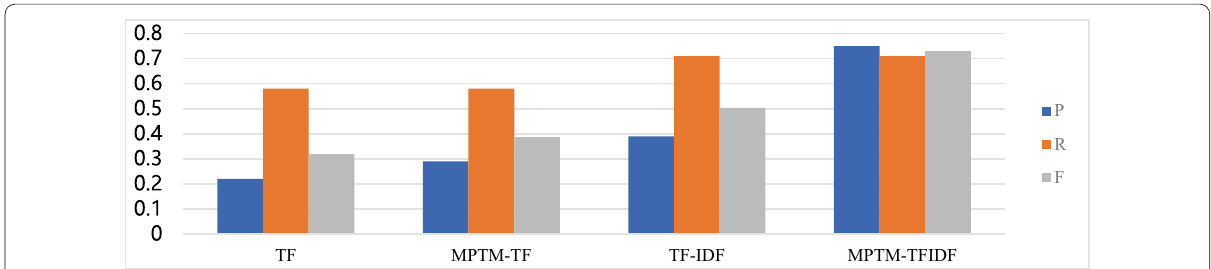
Figure 4 Comparison of four